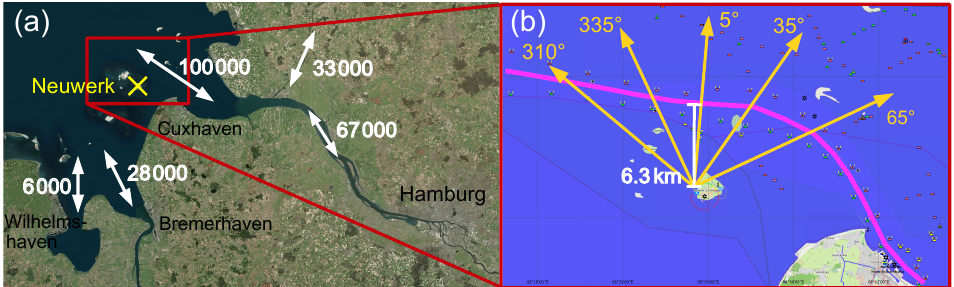
Figure 1. (a) Location of the measurement site Neuwerk in the German Bight, close to the mouth of the river Elbe. White numbers show the number of ship movements (data from 2011/2012). Data source: German Federal Waterways and Shipping Administration (WSV, 2013, 2014). Map source: http://www.bing.com/maps/ (01.04.2014). (b) Azimuthal viewing directions of the MAX-DOAS instrument towards the main shipping lane (highlighted by the magenta line), passing the island in the north at a distance of 6–7km. Map source: http://www. freie-tonne.de (16.07.2013)